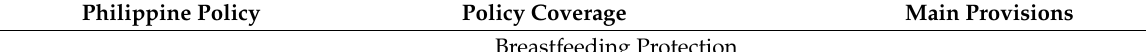
Table A1. Summary of Philippine policies and provisions related to breastfeeding protection, promo- tion, and